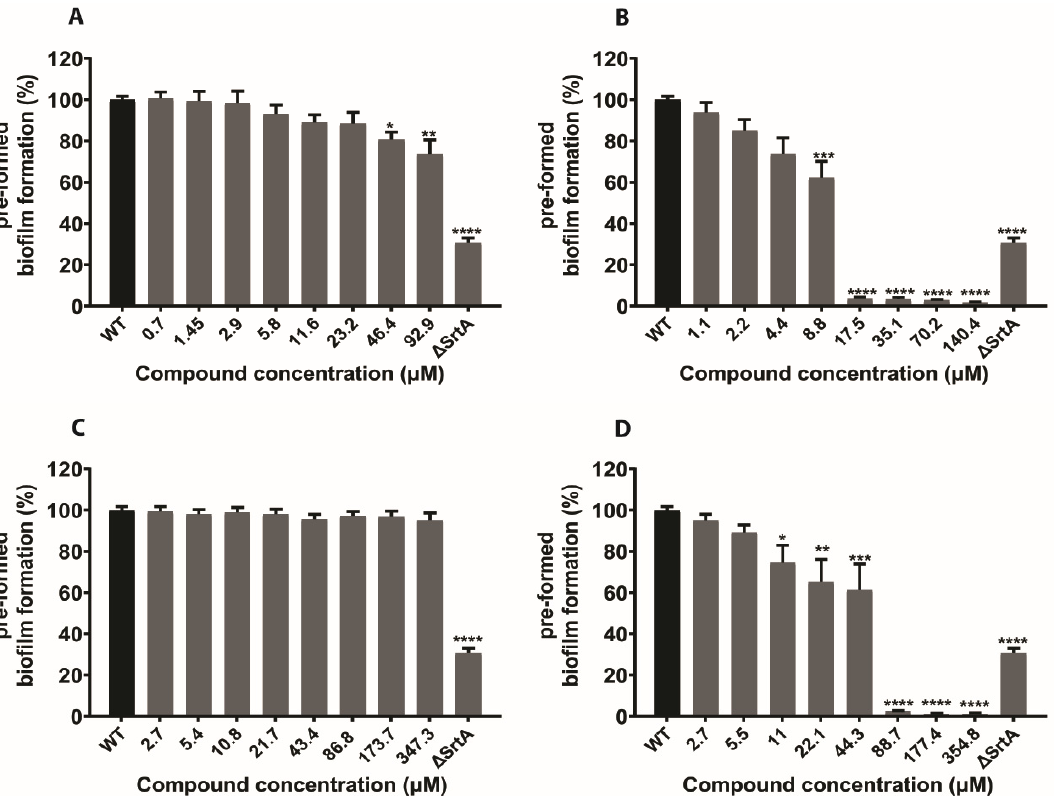
Figure 7. Effect of the known inhibitors of SrtA and selected hits on pre-formed biofilms of S. aureus cells (strain Newman). Inhibition of S. aureus pre-formed biofilm formation was determined using crystal violet staining (CV) assay. N1287 ( A ), N2576 ( B ), curcumin ( C ) and p-HMB ( D ). The results are presented as the mean percentage of biofilm formation ± S.E of six replicates (two independent experiments) relative to the untreated control (wild type). * p < 0.05, ** p < 0.01, *** p < 0.001 and **** p < 0.0001.